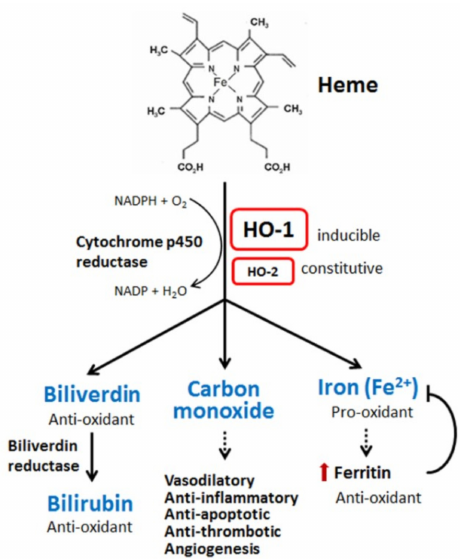
Figure 1. Heme metabolism. Heme is degraded by heme oxygenase (HO), leading to the generation of biliverdin, carbon monoxide, and ferrous iron. Biliverdin is subsequently converted to bilirubin by biliverdin reductase. Under most conditions, biliverdin and bilirubin act as anti-oxidants by scavenging or neutralizing reactive oxygen species (ROS). Carbon monoxide, a gaseous product, mainly functions in signaling transduction, including the vasodilation of blood vessels, production of anti-inflammatory cytokines, upregulation of anti-apoptotic effectors, and thrombosis. Ferrous iron is the major pro-oxidant in all metabolites of heme. However, heme oxygenase-1 (HO-1) activation also increases ferritin expression, which can bind to ferrous iron and detoxify its pro-oxidant effect. The black arrows indicate that biliverdin metabolize into bilirubin. The dotted arrow indicates that carbon monoxide serves a regulator in vasodilatory, anti-inflammatory, anti-apoptotic, anti-thromobtic, and angiogenesis activities. The dotted arrow below iron indicates the iron increase will increase ferritin, which neutralizes the pro-oxidant effect of